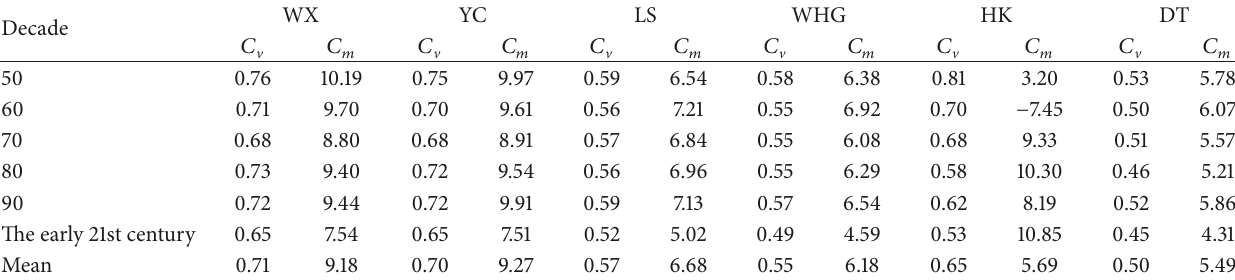
Table 2: The nonuniform coefficient of annual runoff distribution ( 𝐶 V ) and relative variation range ( 𝐶 𝑚 ) in each station in the YRB.